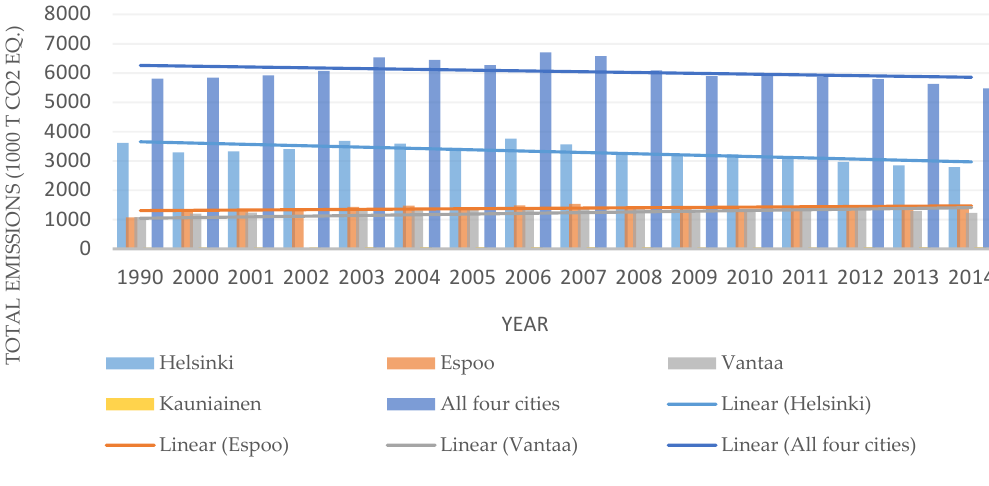
Figure 3. Emissions reduction trends for the cities in the Helsinki metropolitan area from 1990 to 2014 [15].